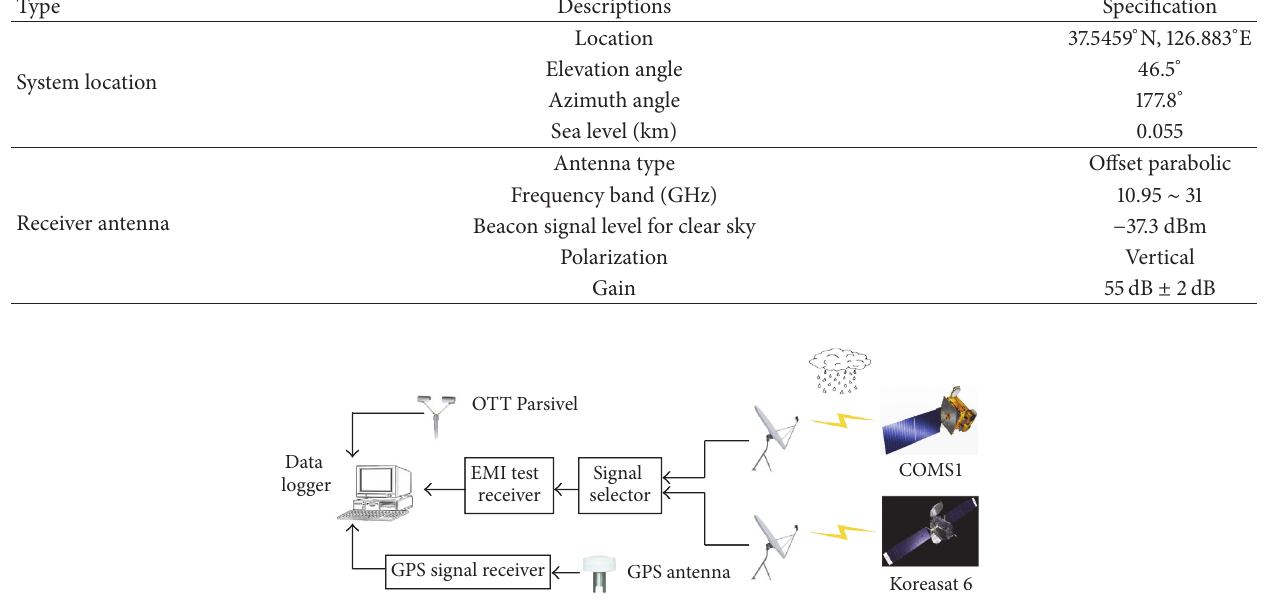
Figure 1: Experimental setup for rain attenuation and rain rate measurement